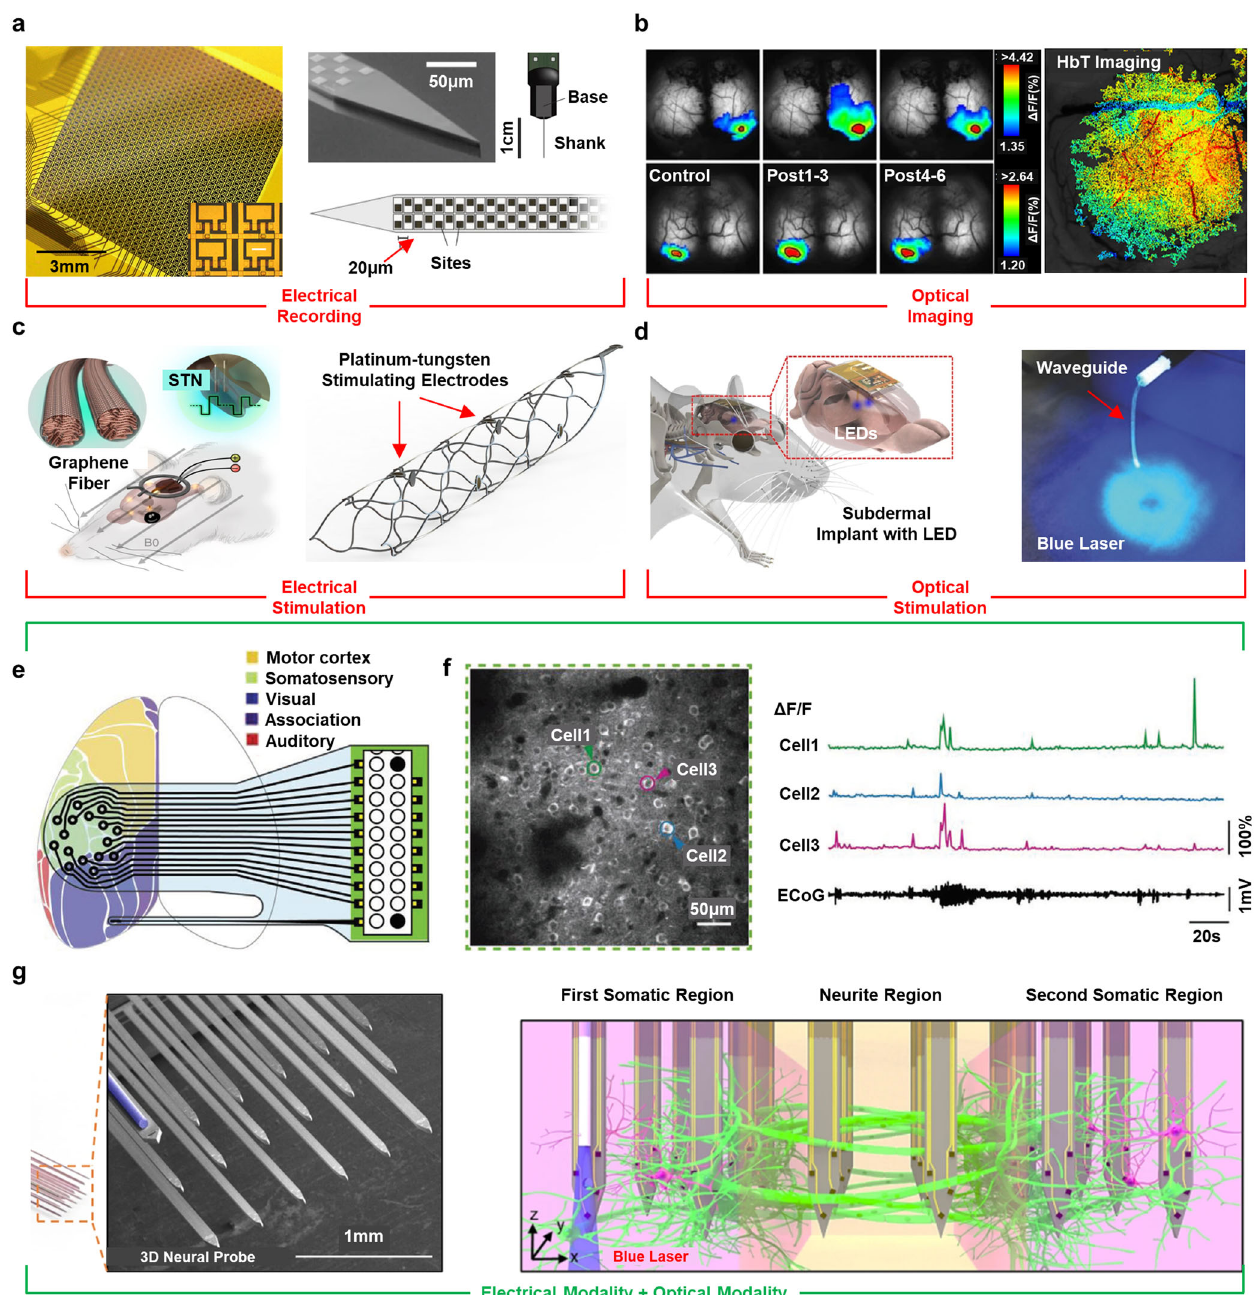
Fig. 2 Integration with electrophysiology and optical modalities by neural implantable device. a High-density active electrode array for electrophysiological brain mapping (left) and a high-density, active-matrix neural probe for deep brain recording (right). b Transcranial Ca 2 + transient imaging from a visual fl ash response of anesthetized mouse (left) and total hemoglobin imaging of a mouse cortex after hind-paw stimulation (right). c Graphene fi ber-based neural electrode for electrical stimulation of subthalamic nucleus (left) and endovascular stent for focal electrical stimulation of the sheep motor cortex (right). d Soft, fully implantable optoelectronic system for light stimulation of nucleus accumbens (left) and ultrasoft-hydrogel optical fi bers for optogenetics stimulation (right). e Stretchable electrocorticography (ECoG) array for simultaneous electrophysiological recording with optogenetics stimulation. f Two-photon fl uorescence imaging of GcaMP6f-labeled neurons from a SNAP25-GCaMP6f mouse (left) and corresponding calcium transient from each cell in colored circles from imaging and ECoG signals from the electrode (right). g Three-dimensional multi-shank probe for simultaneous electrical modality, optical modality, and drug delivery. A magni fi ed image of the device is presented with an optical waveguide (left). The connectivity from a fi rst somatic region to a second somatic region is illustrated with a three-dimensional structure of the multi-shank probe (right). Panel a reprinted with permissions from ref. 48,49 , AAAS (left) and Springer Nature (right). Panel b reprinted with permissions from ref. 50,51 , Springer Nature (left) and Elsevier (right). Panel c reprinted with permissions from ref. 77,78 , Springer Nature. Panel d reprinted with permissions from ref. 81,82 , Springer Nature (left) and Wiley (right). Panel e and f reprinted with permissions from ref. 85 , Wiley. Panel g reprinted with permissions from ref. 86 , Springer